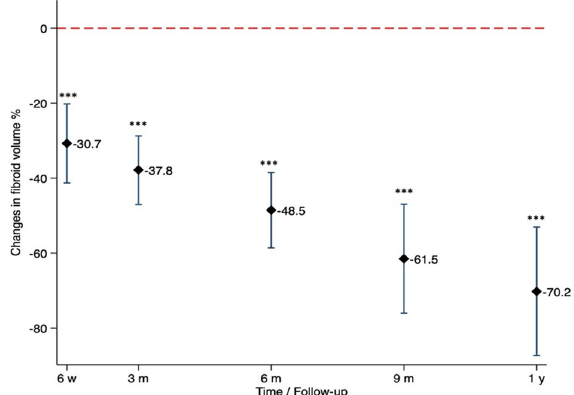
Figure 3. Changes in fibroid volumes during follow up. Significant fibroid volume reduction rate was observed 6 weeks after HIFU compared to baseline (95% CI: − 52%, − 74%, p < 0.05). Lesion shrinkage improved continuously over the observational period at 3-, 6-, 9-month and 1-year follow-up (each p < 0.001, compared to baseline, mixed model). The figure was created using Stata 16 Software (StataCorp. 2019. Stata Statistical Software: Release 16. College Station, TX: StataCorp LLC).